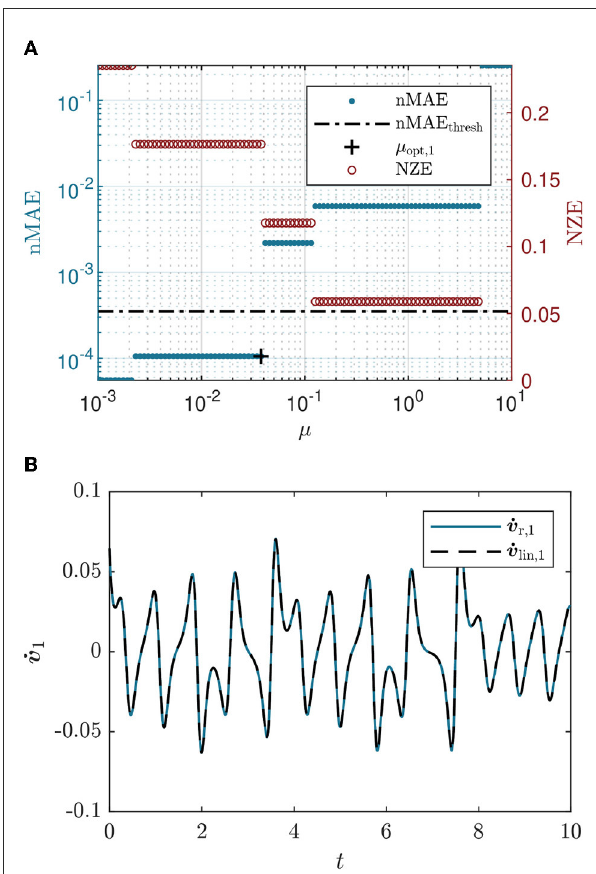
FIGURE4 (A) Determination of an optimal sparsification threshold µ . The optimization is performed for each column of the sparse regression separately, the image shows the process for the first column only. The sparse regression is performed 100 times with different values of µ ∈ [0.0001,1] to obtain 100 different versions of a vector of sparse coefficients ξ j . As a measure for accuracy, the nMAE of the resulting approximated derivative ˙ v lin,1 with its corresponding true derivative ˙ v r,1 is computed for each variation of µ . The relative number of non-zero elements (NZE) in the vector of sparse coefficients is a measure for model sparsity. By hard-threshold the nMAE at a value nMAE thresh , a suitable µ for the given column is chosen. (B) Results of the sparse regression. The approximated derivative ˙ v lin,1 obtained with the indicated µ opt,1 compared to the corresponding true derivative ˙ v r,1 .